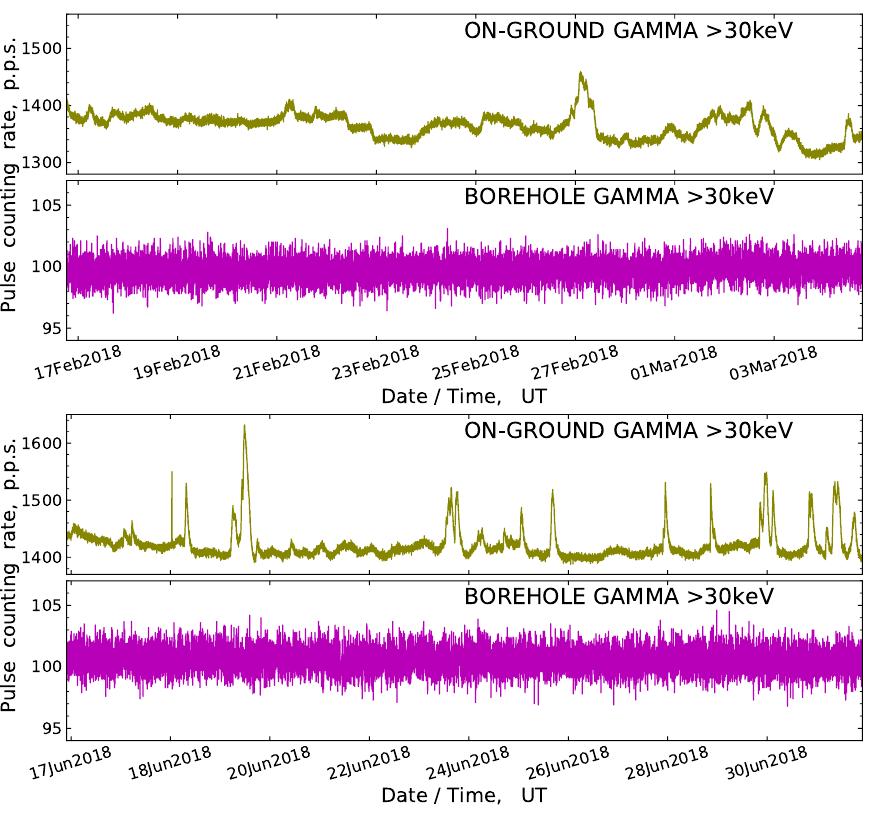
Figure 2. Comparison of radiation intensity measurements which were simultaneously done by the gamma detectors installed above the surface of the ground and in the borehole. Upper frame : a 17-day-long period randomly taken in a winter season. Lower frame : similar comparison for summer season. All intensity values are expressed in the amount of pulse signals gained per one second (p.p.s.) in the corresponding energy